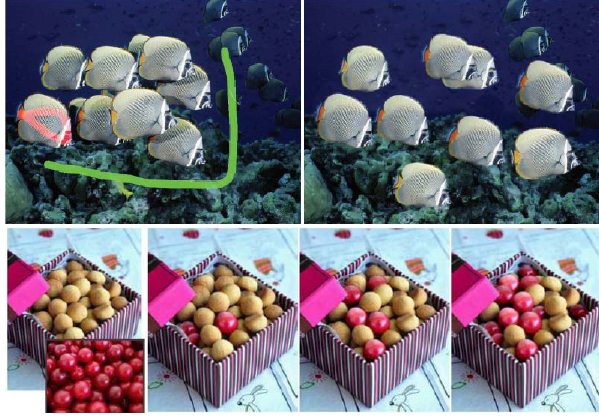
Editing repeated elements in an image. Above: RepFinder [38] uses patch-based methods to complete the